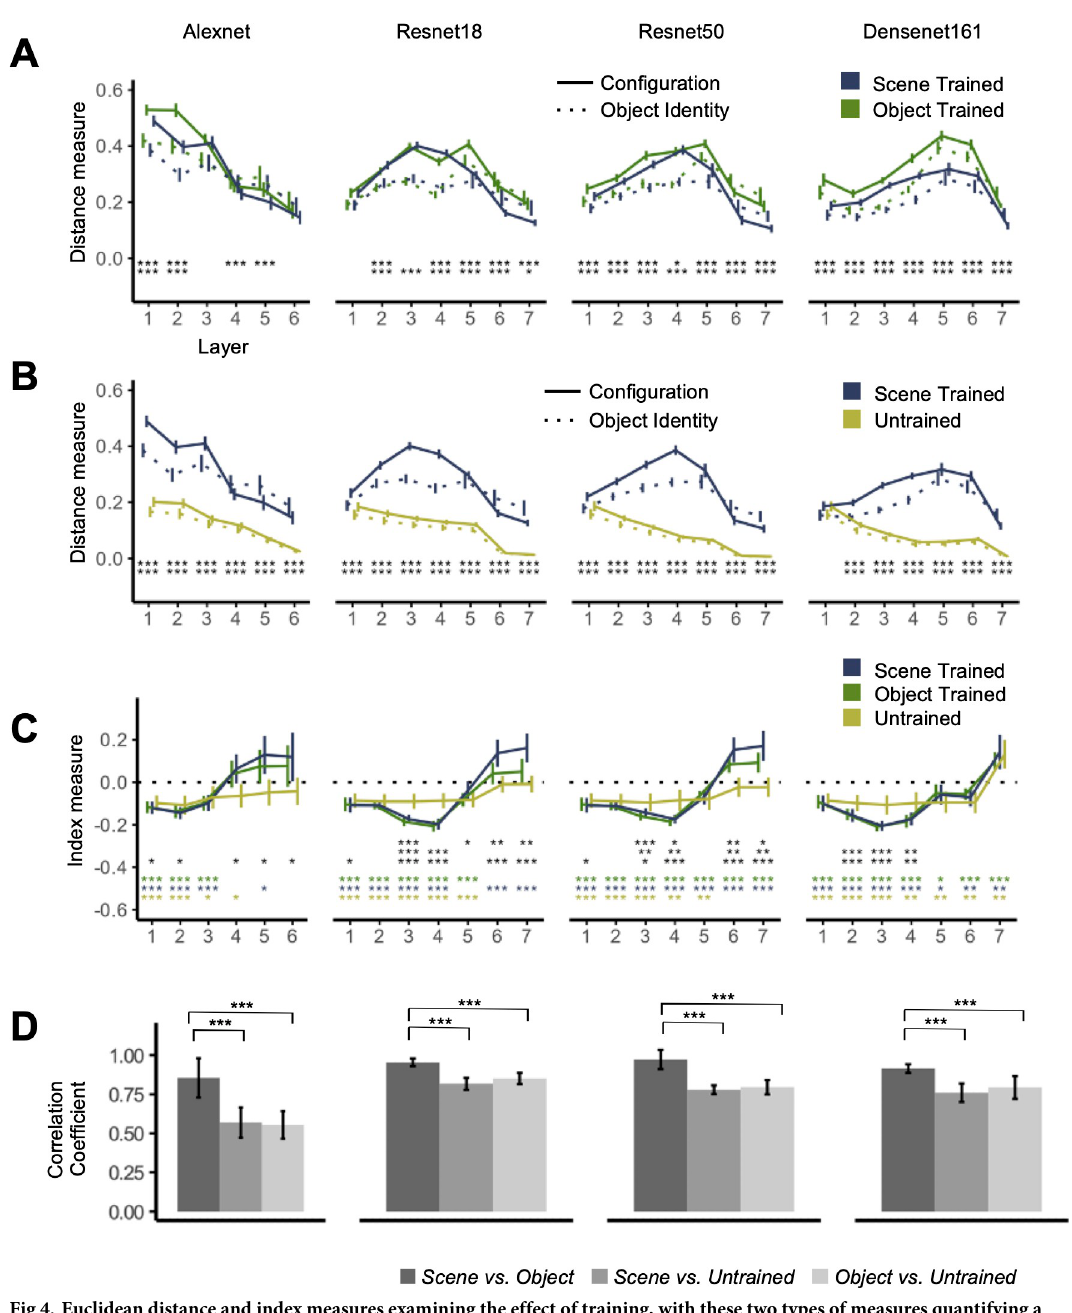
Fig 4. Euclidean distance and index measures examining the effect of training, with these two types of measures quantifying a CNN’s absolute and relative sensitivity to object identity and configuration changes, respectively. The Euclidean distance for “Configuration” was calculated as the distance between two images sharing the same objects but different configurations. The Euclidean distance for “Object Identity” was calculated as the distance between two images sharing the same configuration but different objects. The object dominance index measured the relative sensitivity to object identity and configuration changes, with negative values indicating greater sensitivity to configuration than identity changes and positive values the reverse. ( A ) Euclidean distances for the scene-trained and object-trained CNNs. ( B ) Euclidean distances for the scene-trained and the untrained CNNs. ( C ) The object dominance indices for the different training regimes. ( D ) Pairwise correlations of the object dominance index curves across CNN layers for the three training regimes. The asterisks indicate the significance levels of the pairwise comparisons at each sample CNN layer using two-tailed t tests (all corrected for multiple comparisons). In (A) and (B), the top row is from comparing “Configuration” across the two types of training, and the bottom row is from comparing “Object Identity” across the two types of training. All values were significantly non-zero (ts > 10 , ps < . 001) . In (C), the asterisks from the top to bottom rows indicate, respectively, differences between scene-trained and object trained CNNs, between object-trained and untrained CNNs,